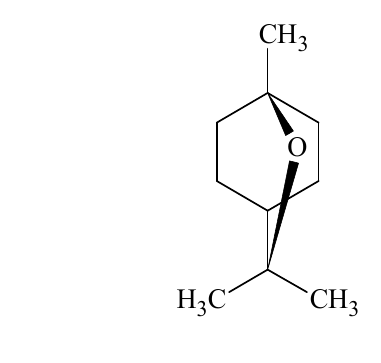
Figure 6. Chemical structure of